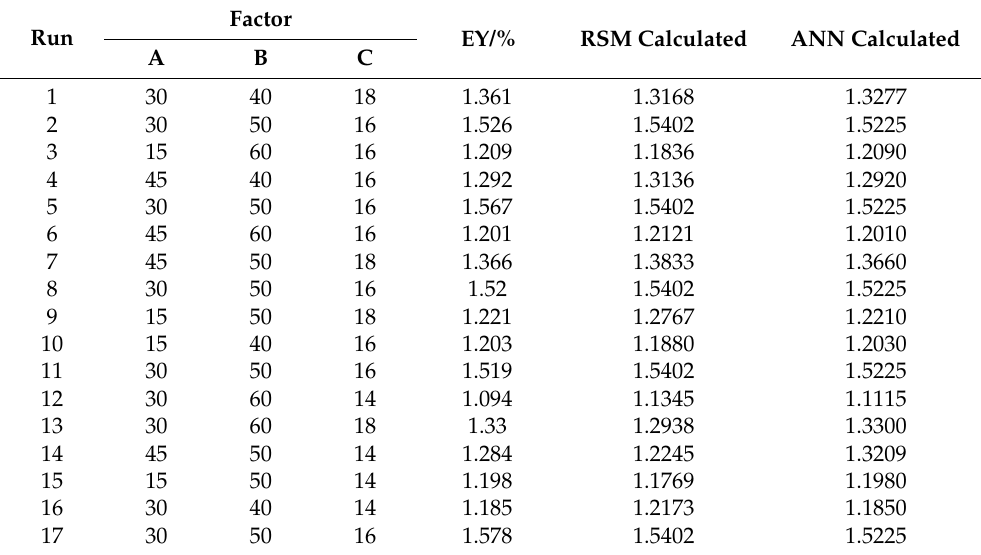
Table 4. Results of the Box–Behnken design (BBD) for the extraction yield of UA and ANN